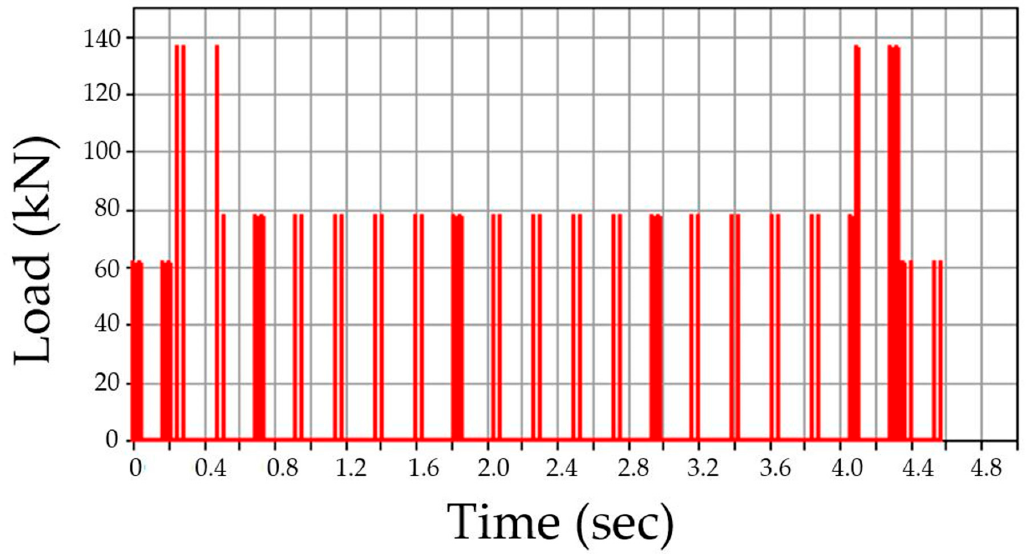
Figure 6. Time histogram function results for the finite element analysis